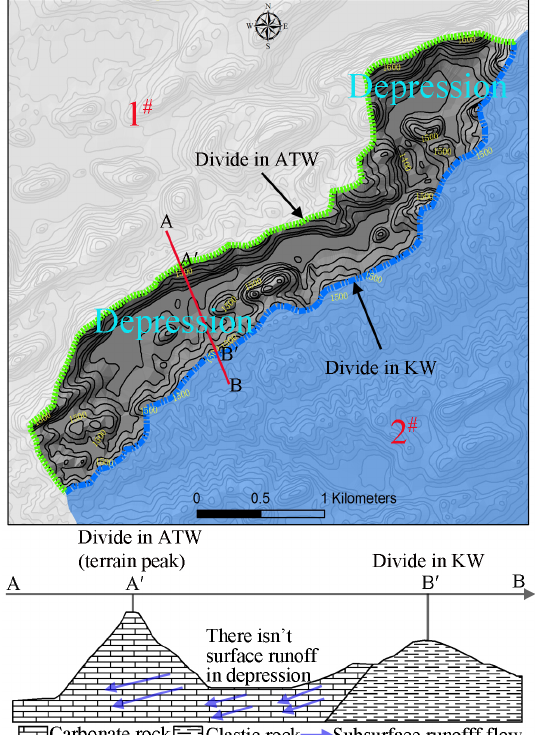
Figure 3. Process used to determine the trunk stream of the dual structure of the surface and subsurface in karst watersheds (KW). ATW represents “auto-delineating topographic watersheds”.